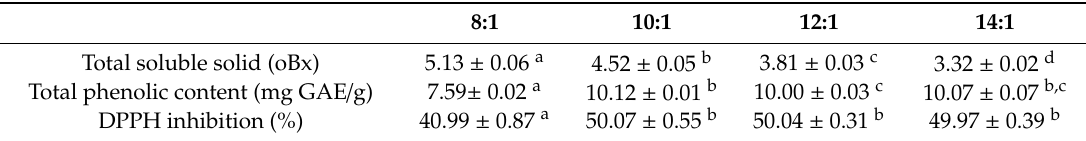
Table 4. E ff ects of liquid-solid ratio (ml / g) on the characteristics of the Roselle tea.